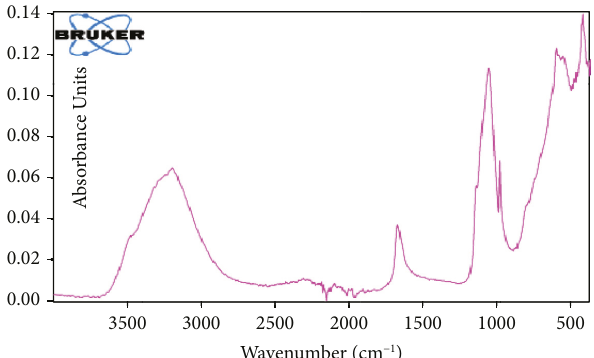
Figure 11: Activated carbon after adsorbing dieldrin.